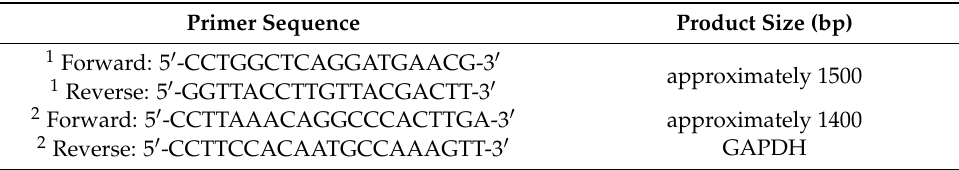
Table 1. Primer sequences for quantitative real-time polymerase chain reaction.